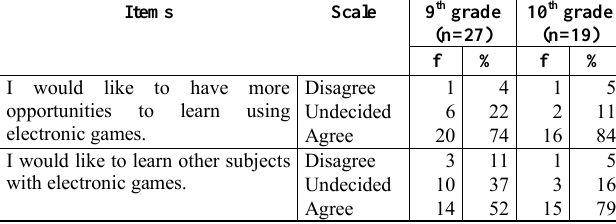
Table 8. Students cognitive development and video